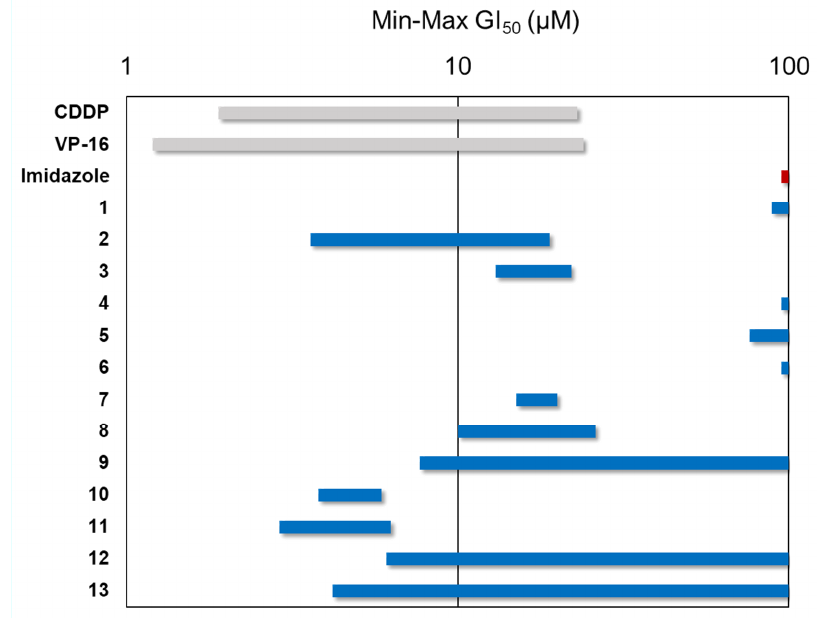
Figure 3. GI 50 range plot of the tested compounds.